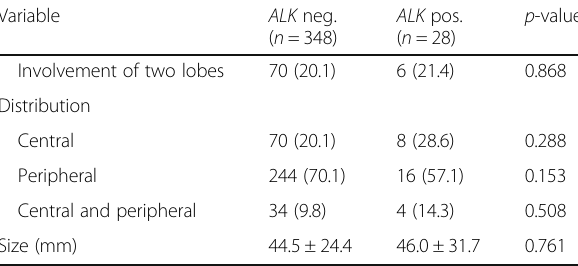
Table 8 Associations between clinicopathological features and ALK rearrangement